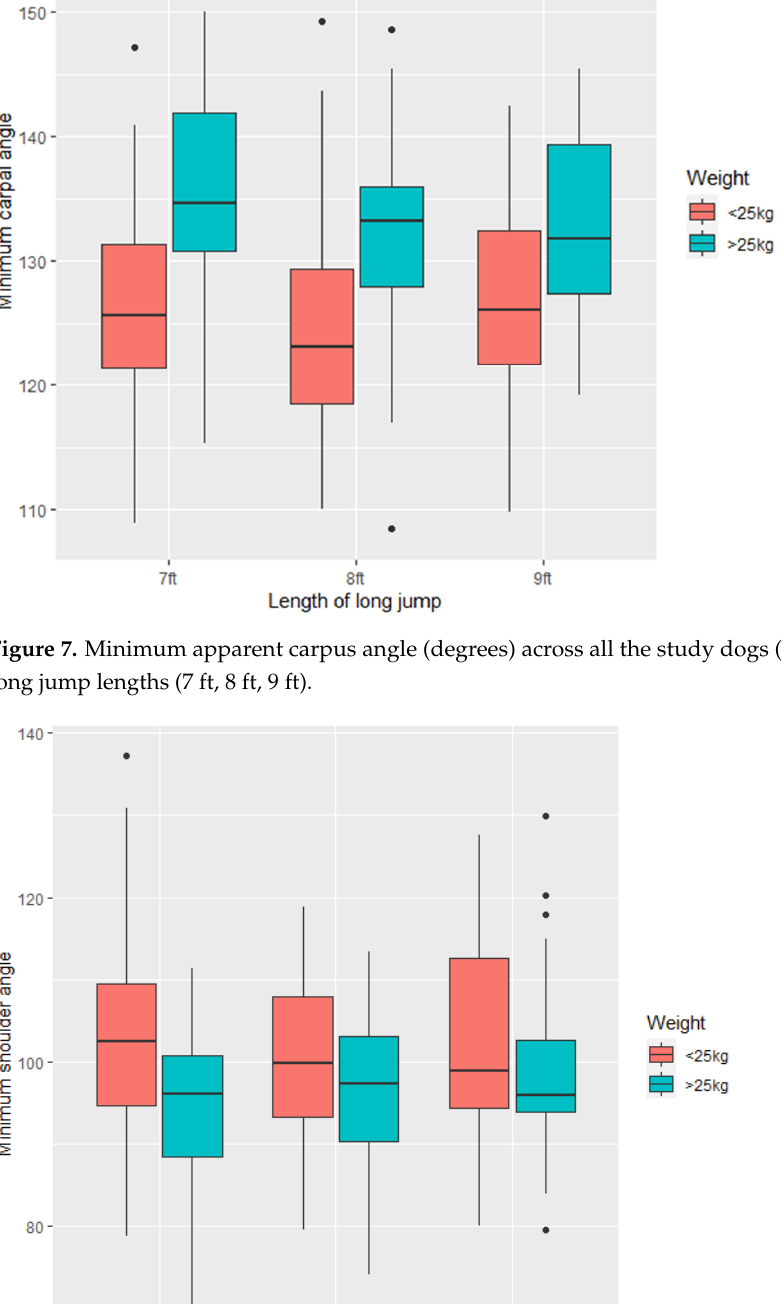
0.0154) (Figure 9).